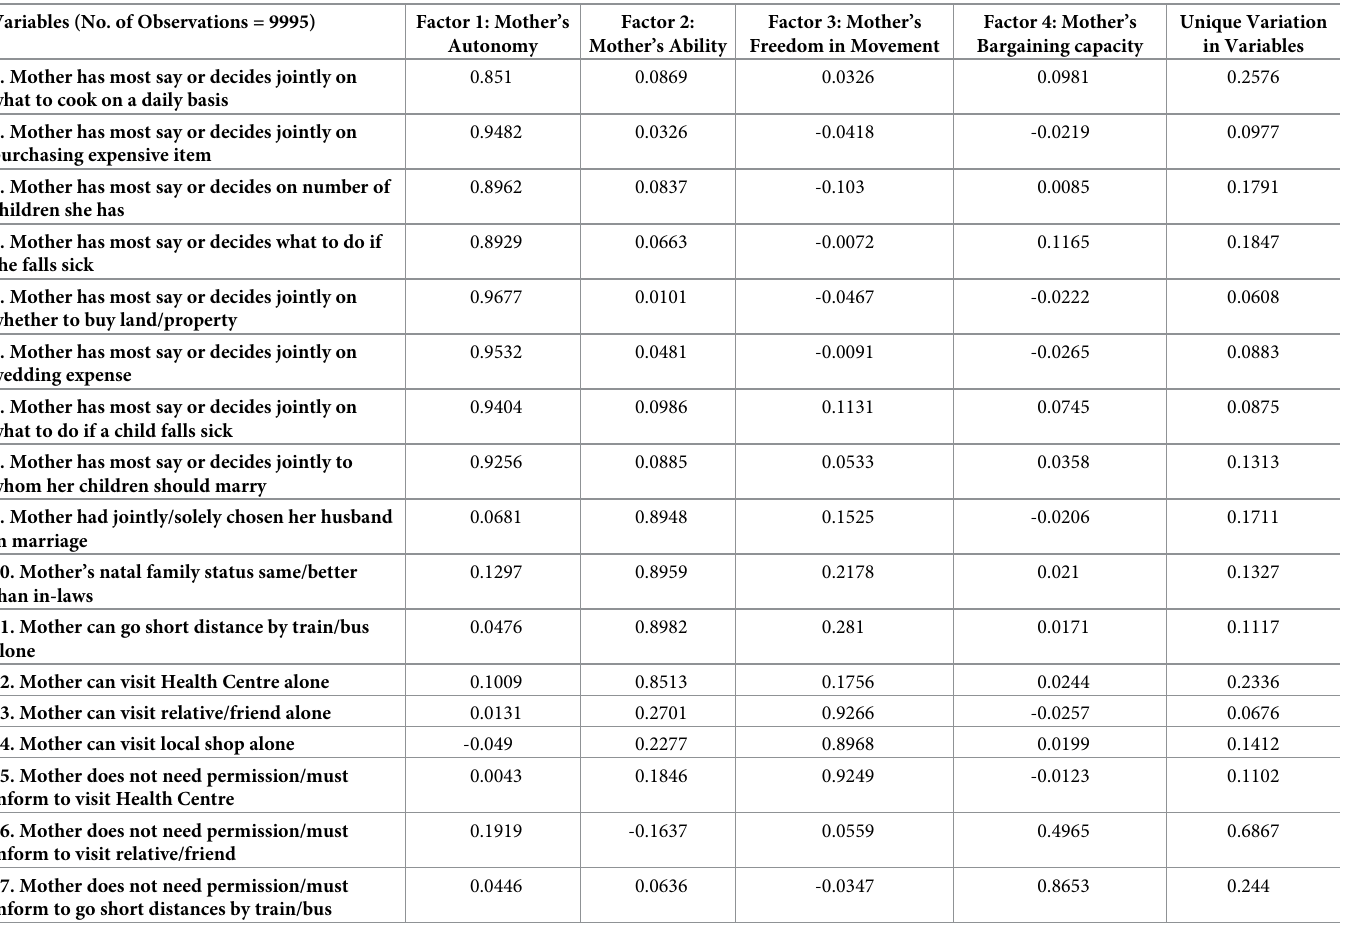
Table 1. Mother’s autonomy, ability and freedom: Rotated factor loadings (pattern matrix) and unique variances. Variables (No. of Observations =